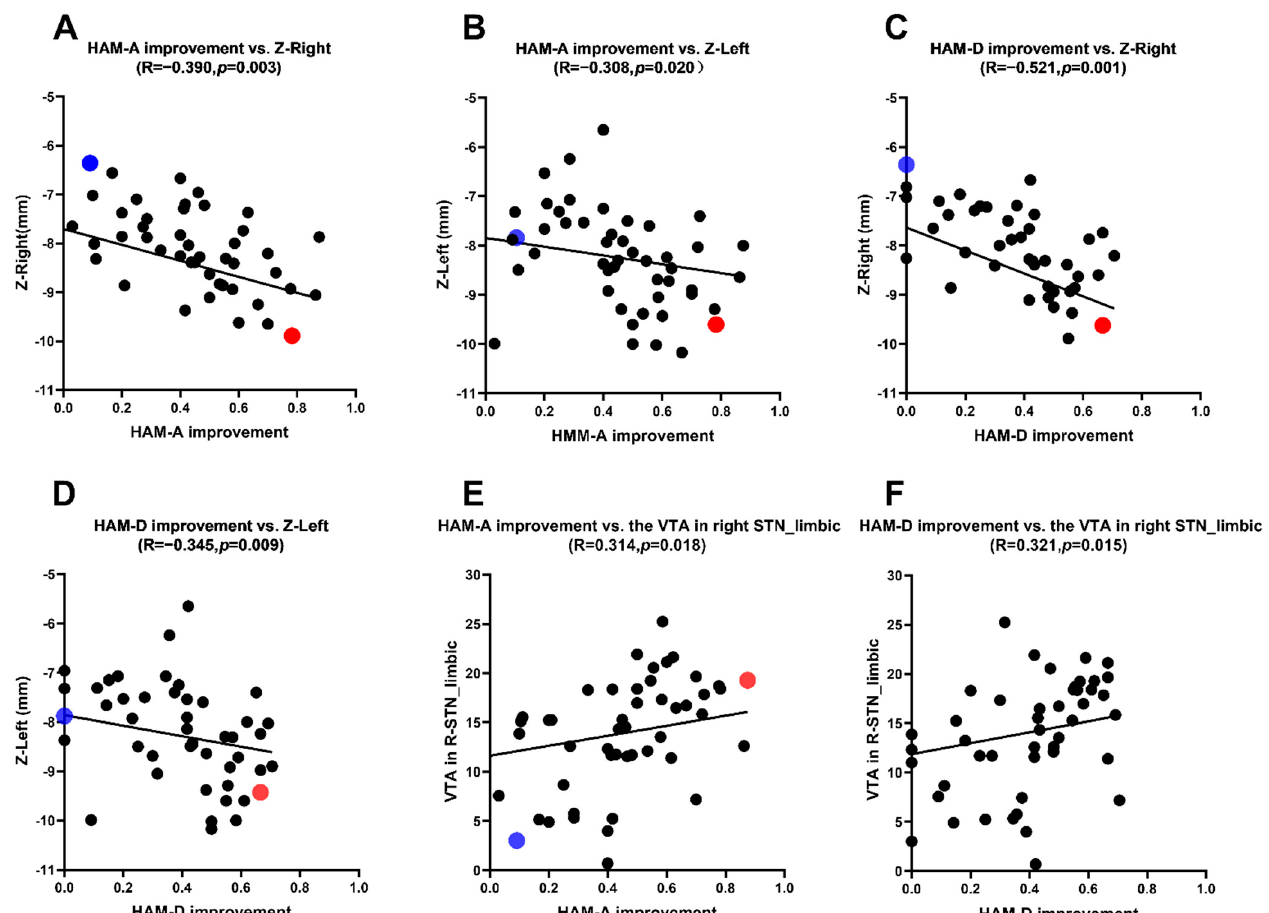
Figure 2. ( A , B ) Correlation analysis between the HAM-A scores improvement rate and the Z-axis coordinate. ( C , D ) Correlation analysis between the HAM-D scores improvement rate and the Z-axis coordinate. ( E ) Correlation analysis between the HAM-A scores improvement rate and the VTA of limbic STN. ( F ) Correlation analysis between the HAM-D scores improvement rate and the VTA of limbic STN.